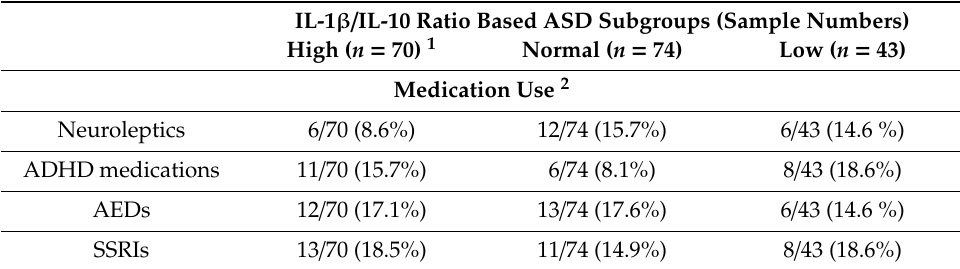
Table 2. Frequency of medication use in the IL-1 β / IL-10 based ASD subgroups. IL-1 β / IL-10 Ratio Based ASD Subgroups (Sample